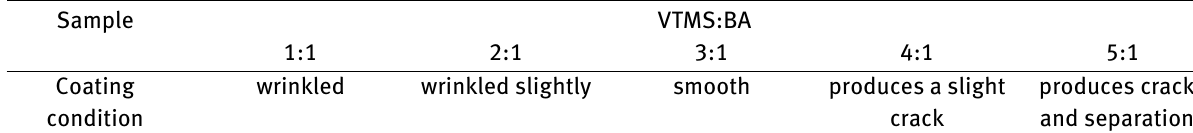
Table 1: The film formation of different proportions of UV curable acrylate / vinyl trimethoxy silane coatings Sample